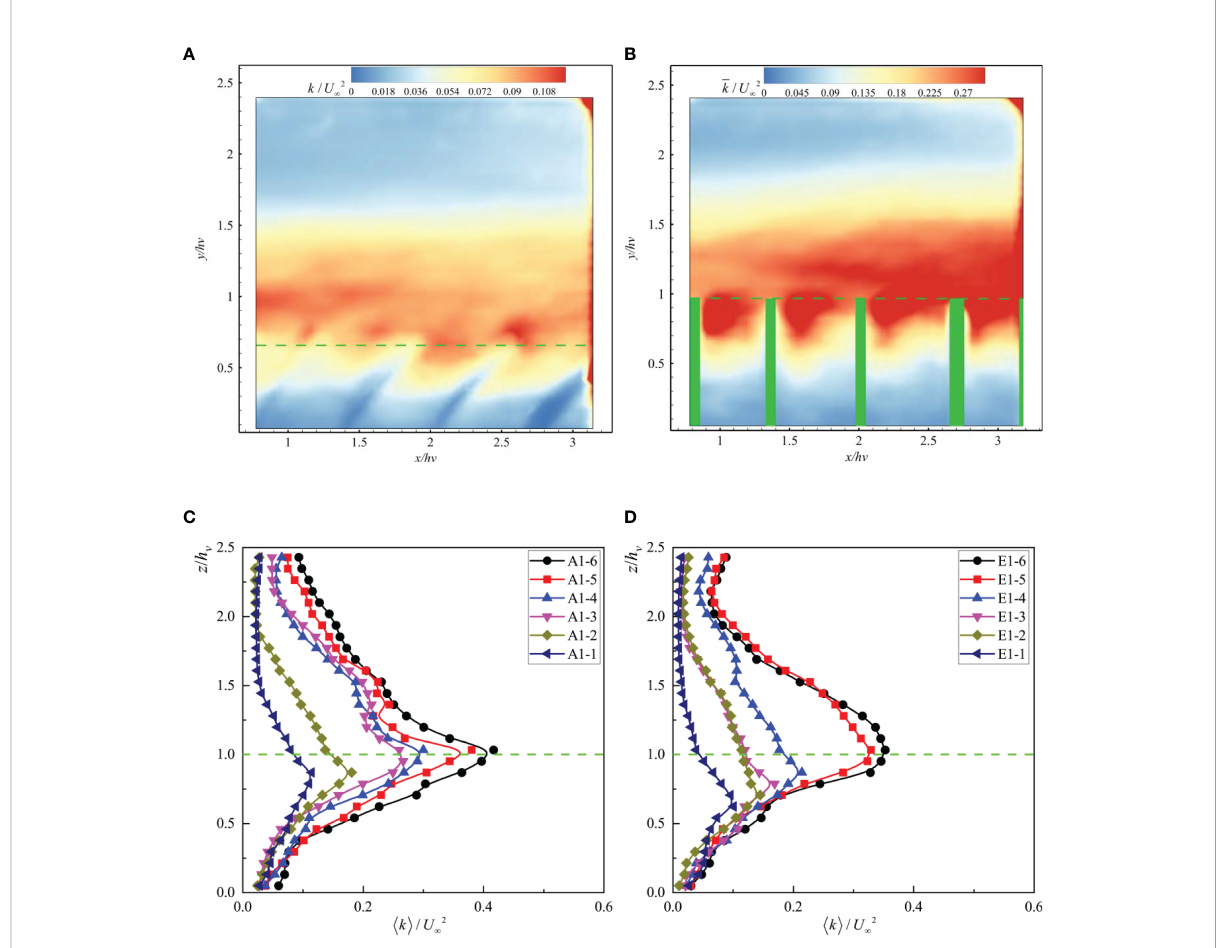
FIGURE 7 The distribution of dimensionless time-averaged turbulent kinetic energy k = U 2 ∞ under (A) E1-1 and (B) E1-5 and the dimensionless double- averaged turbulent kinetic energy, 〈 k 〉 = U 2 ∞ , under (C) Test A and (D) Test